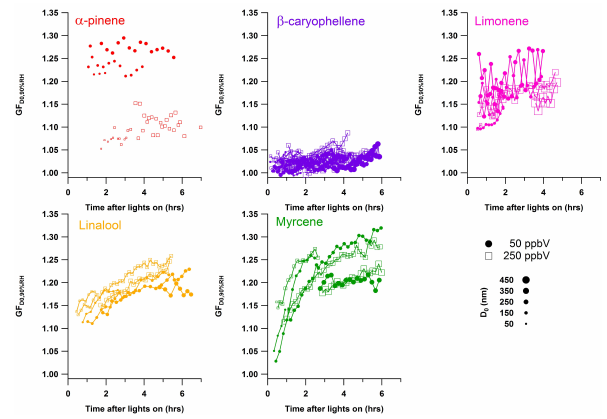
(GF D 090% ) of the SOA particles from the five studied biogenic pre-